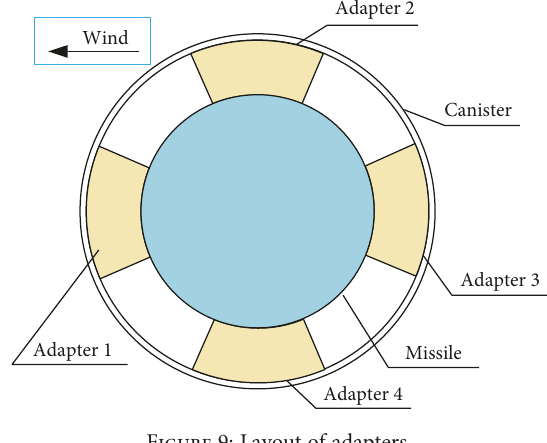
Figure 9: Layout of adapters. Table 2: The placement data of adapters.